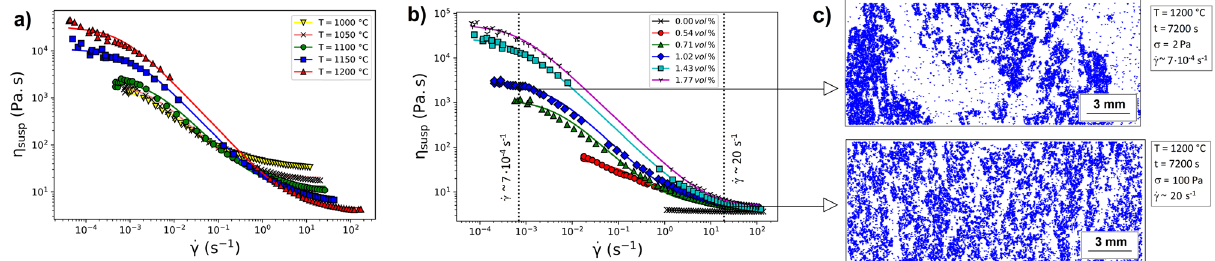
Figure 1. The viscosity of silicate melts suspending PGE-bearing particles as a function of shear strain rate: ( a ) the effect of temperature (Hanotin et al. 17 ), ( b ) the effect of PGE-bearing crystal volume percent (Puig et al. 15